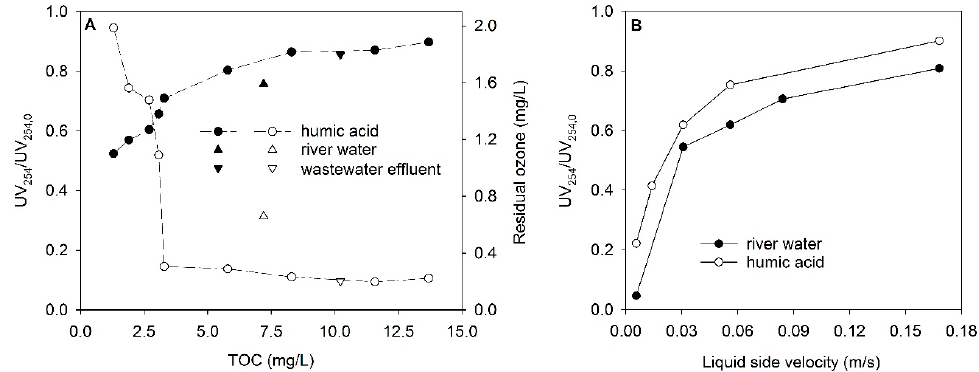
Figure 5. ( A ) Relative change in UV 254 absorbance (closed symbols) and residual ozone concentration (open symbols) for river water I (pH 7.2), wastewater effluent (pH 7.9) and humic acid solutions (pH 7.1) at different TOC, 1.6 mm ID membrane, 4 s residence time, 110 g/m 3 ozone gas concentration. ( B ) Relative change in UV 254 absorbance at different liquid side velocity for river water II (TOC 4.3 mg/L, pH 8.2) and humic acid (TOC 3.6 mg/L, pH 7) for a 1.6 mm ID membrane and 200 g/m 3 ozone gas concentration. TOC: total organic carbon, ID: inner diameter.